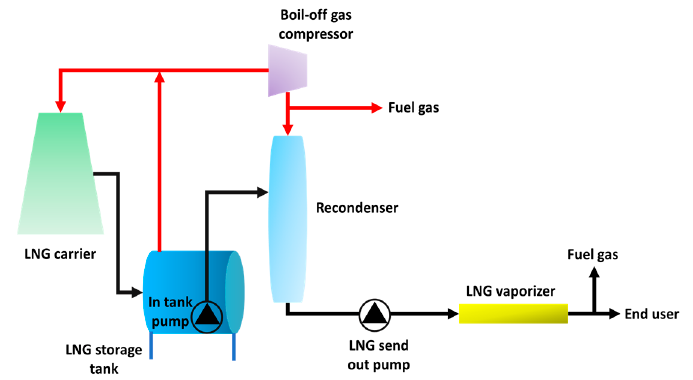
Figure 1. Overall LNG processing from refinery to end user.